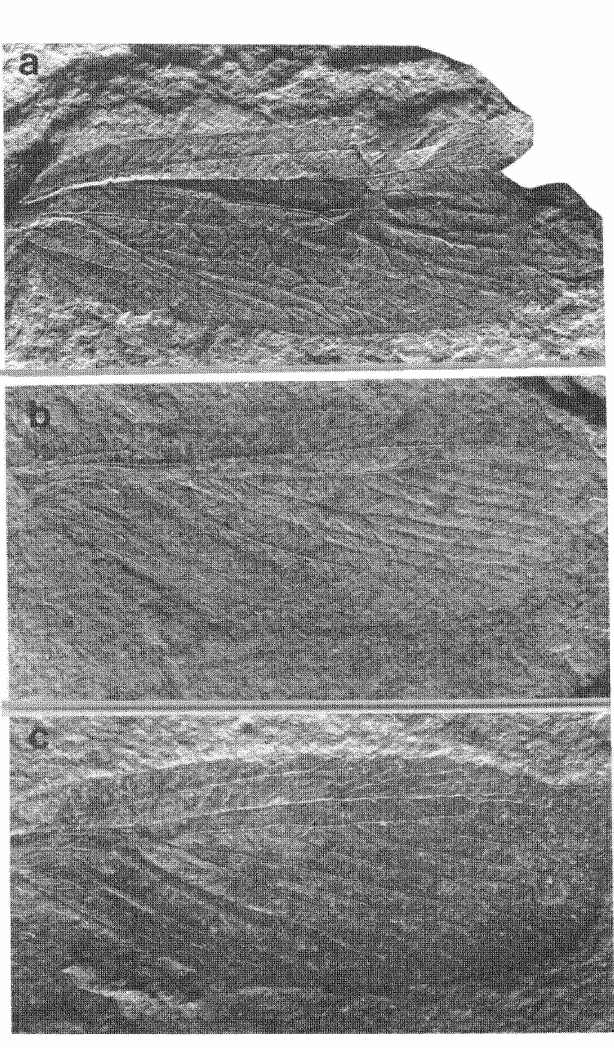
Fig. 17. Gerarus.[’ischeri, a. photograph of fore wing, specimen IP 19. Length 42 mm, as preserved, b. photograph of hind wing, specimen IP 10. Length 40 mm, as preserved, c. photograph of hind wing, specimen P 2. Length 40 mm, as preserved. Note the small triangle formed by the anastomosis of one branch of RS with the main stem of